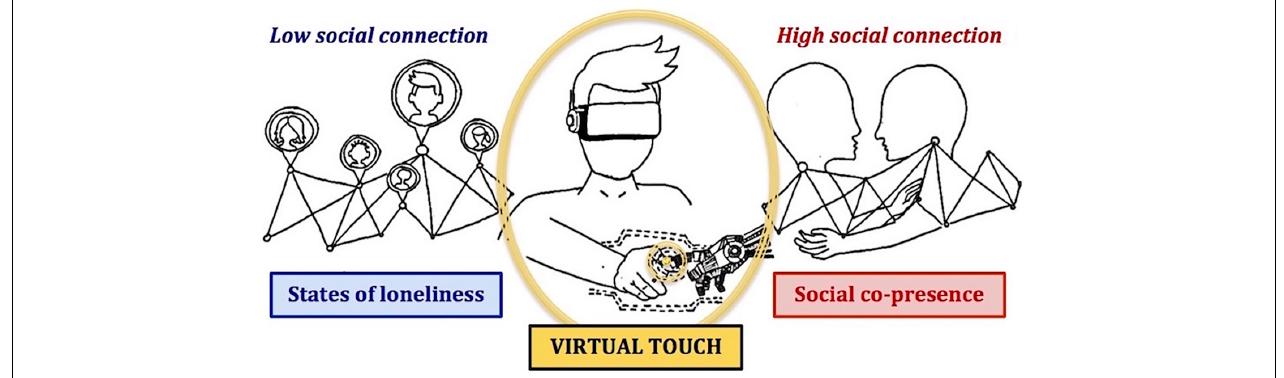
FIGURE 1 | Schematic representation of an integrative perspective on the applicability of interpersonal affective touch in virtual reality (VR) as a potential driver of self-other